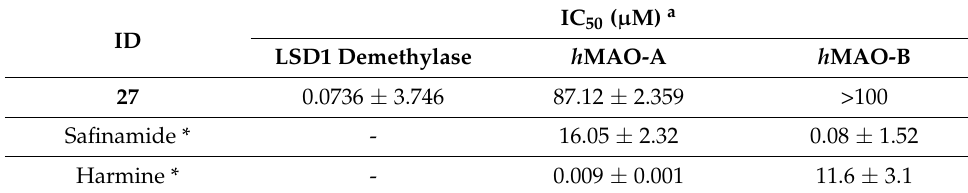
Table 5. Target MAO selectivity assay of compound 27